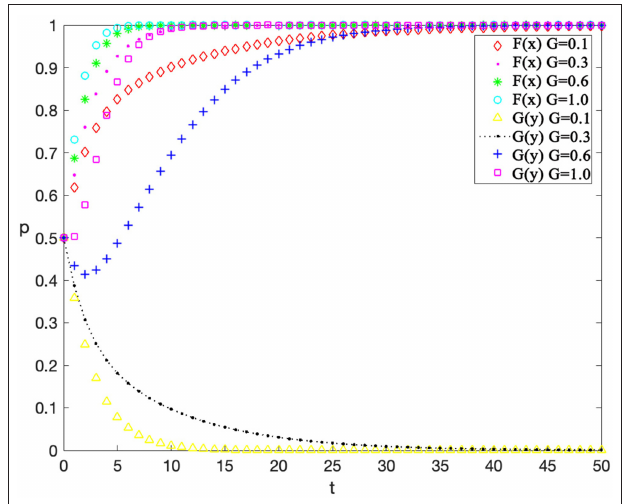
FIGURE 9 | The evolutionary trajectories influenced by